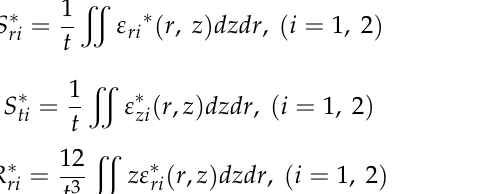
Figure 4. Strain distribution in the weld nugget predicted by process simulation. ( a ) The z-strain; ( b ) The x-strain.